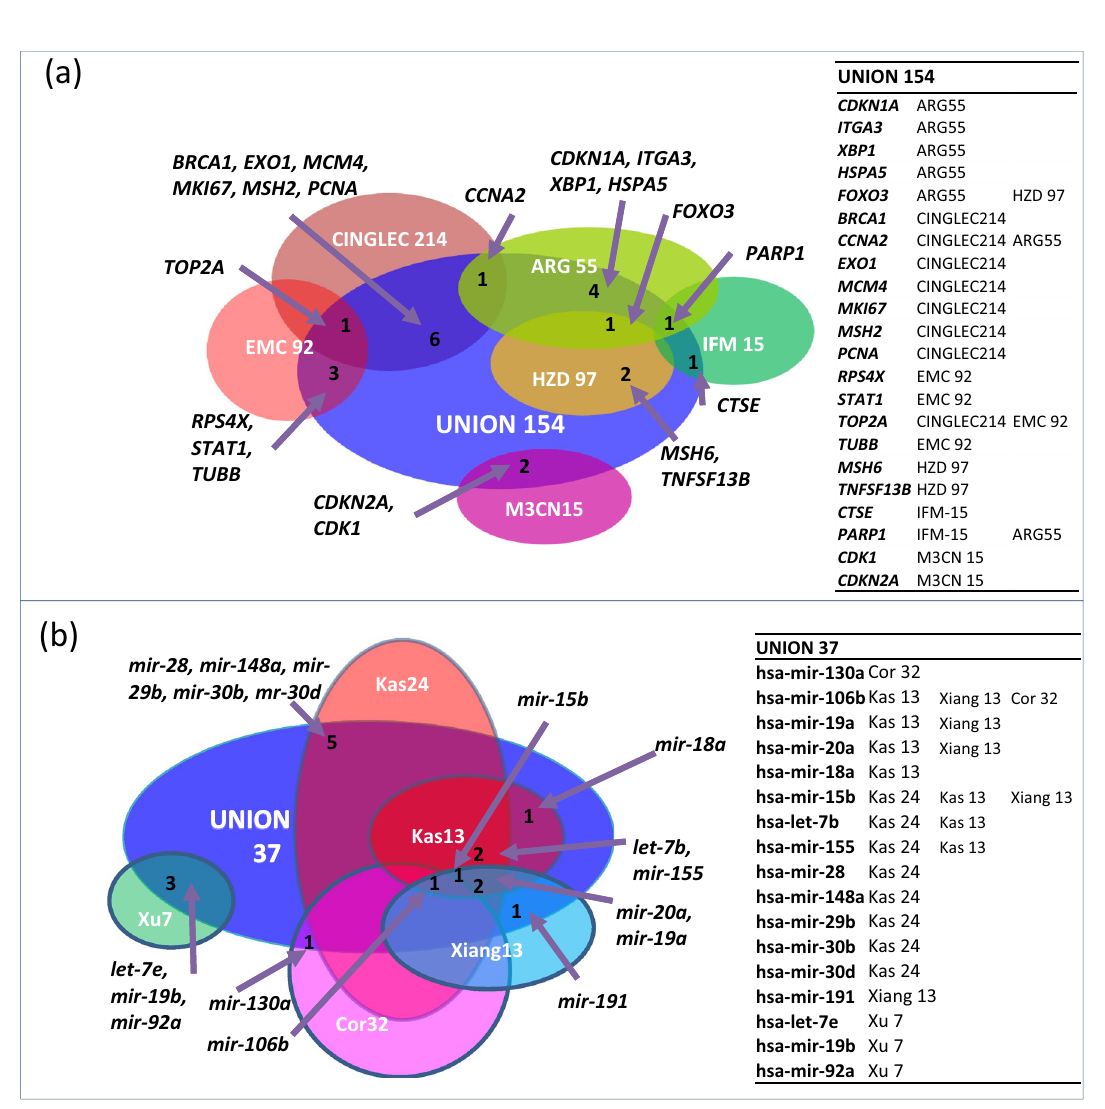
Figure 3. A comparison of commonality between ( a ) Union 154 DEG and ( b ) Union 37 DEM signatures found in this study with analogous published signatures showing an overlap of 22 DEGs and 17 DEMs, respectively 9,10,14,16,17,21,25,26,28,54